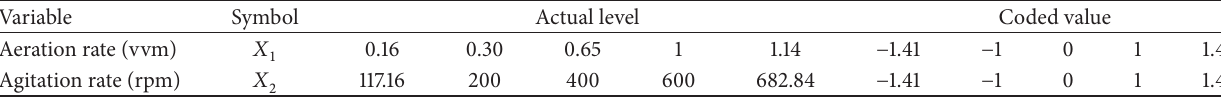
Table 1: Process variables and determined levels for central composite